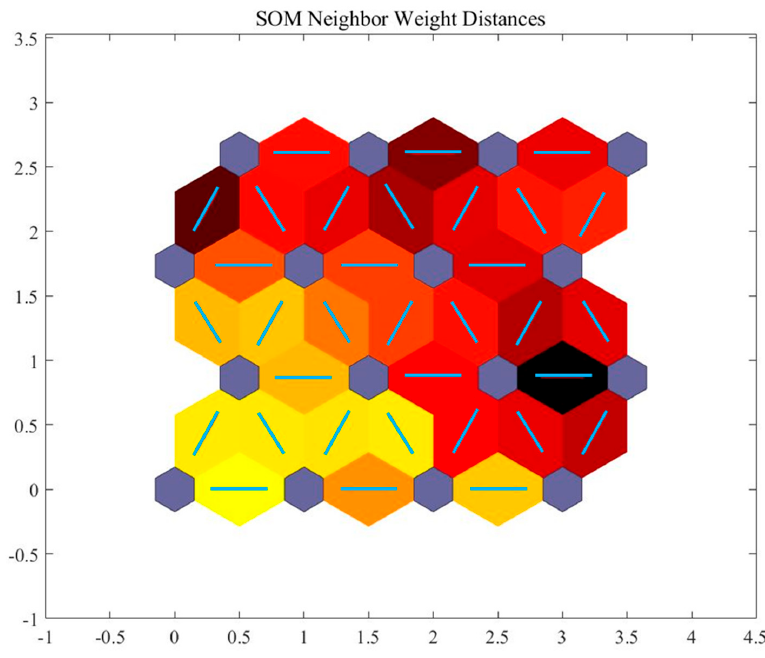
Figure 5. Weight distance map between SOM neighboring neurons.